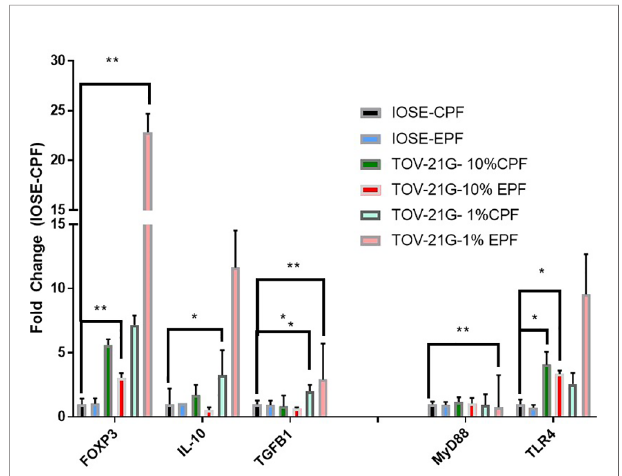
FIGURE 3 | Peritoneal fl uid induces FoxP3 and TLR pathway genes in TOV- 21G cells. *p < 05; **p <